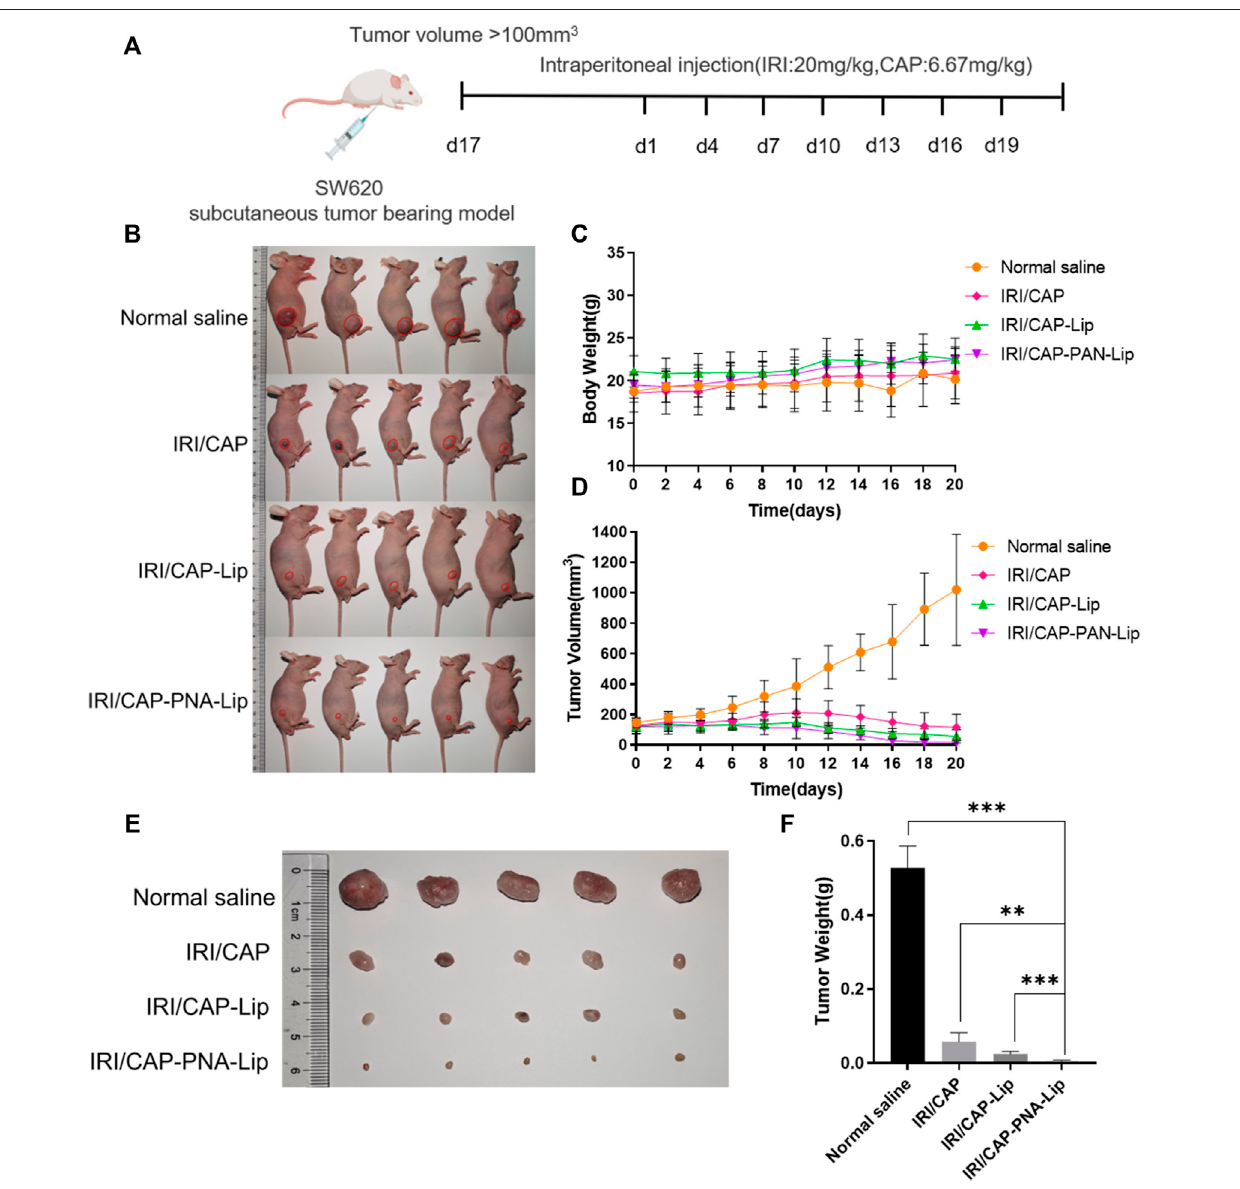
FIGURE9| PNA-modi fi edliposomessigni fi cantlyenhancetheantitumor ef fi cacyofthedrug. (A) DesignprinciplesfortheanalysisoftheantitumorabilitiesofPNA- modi fi ed liposomes in vivo . (B) Photos of tumor-bearing nude mice in each group after 20 days of treatment. (C) Changes in the bodyweight of the tumor-bearing nude mice. (D) Folding line graph ofthe change in tumor volume. (E) Photographs oftumors. (F) Histograms oftumor weights. The data are presented asthe mean ± SD (n = 5). **p < 0.01. ***p < 0.001.